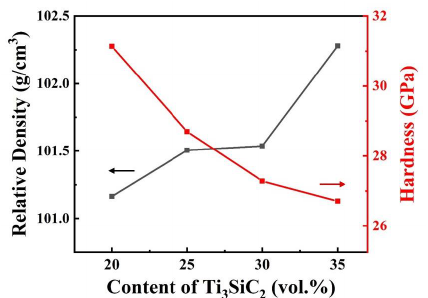
Figure 5. Relative density and hardness of the B 4 C–TiB 2 composite ceramics sintered with different contents of Ti 3 SiC 2 .